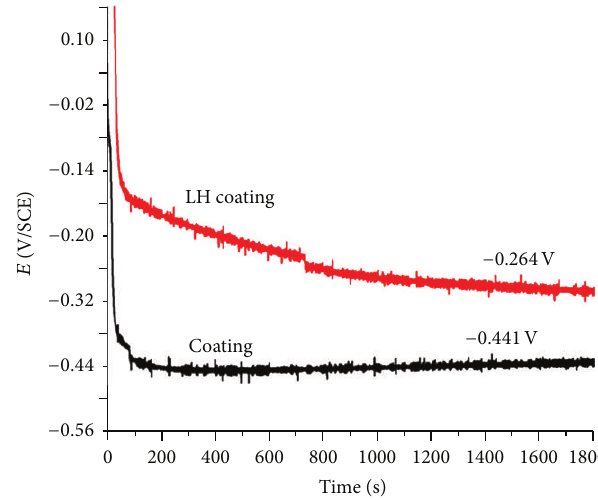
Figure 7: Corrosion potential and time of coating and LH coating in sea water (3.5%